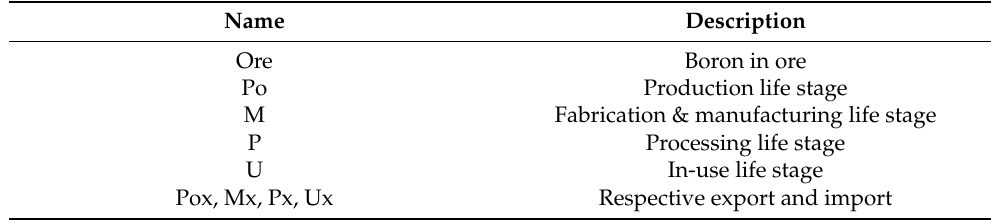
Figure 3. General MFA frame for boron minerals. Table 1. Flows in the generic MFA